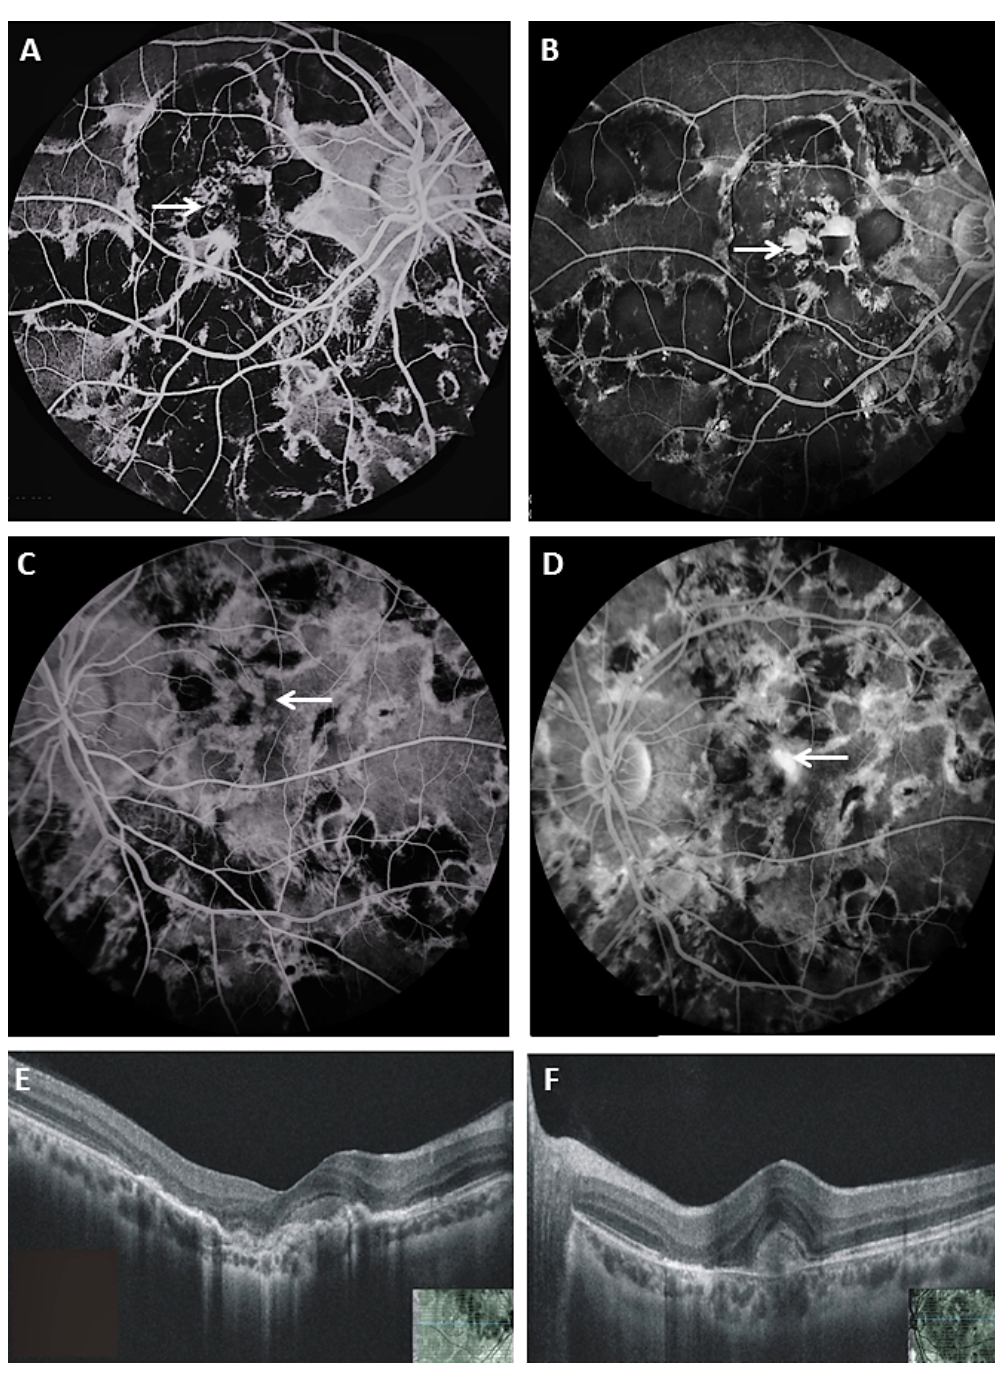
Figure 2: FFA of the right eye in arterio-venous phase (A) showing hypofluorescent patches with hyperfluorescent borders and an area of blocked fluorescence at the fovea with surrounding punctate fluorescence (white arrow) that increases and leaks in late phase (B) suggestive of CNVM. FFA of the left eye (C–D) also reveals a juxta-foveal area of hyperfluorescence (white arrow) compatible with CNVM. OCT line scan through the fovea at presentation shows a subfoveal hyperreflective membrane with overlying trace fluid and mild retinal thickening in the right eye (E) and the left eye